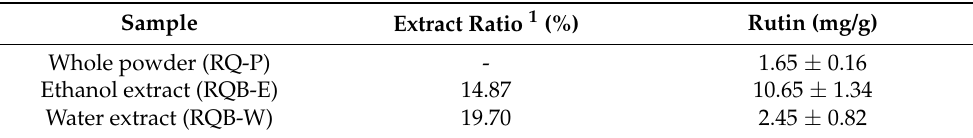
Table 1. The extraction yield and rutin content of red quinoa powder and its bran